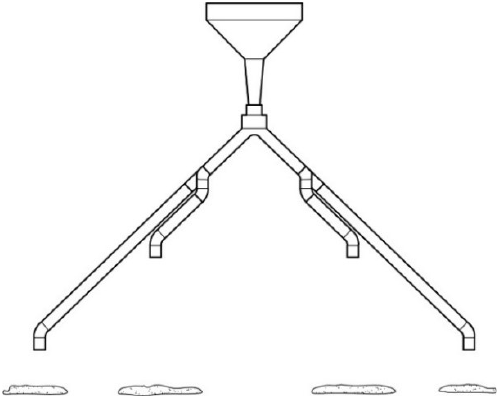
Figure 1. Live black soldier fly larvae dispenser.